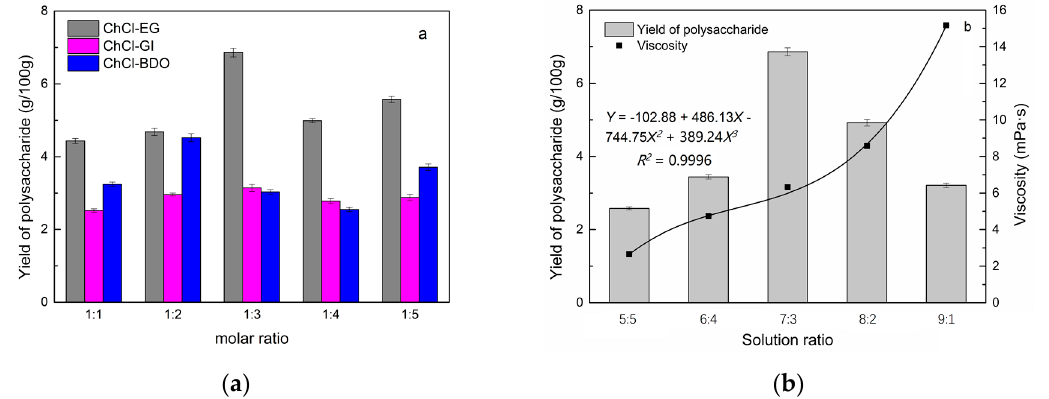
Figure 1. Screening of DES: ( a ) Effect of DES composition on the extraction yield of polysaccharide, ( b ) effect of water amount in the DES solution on the extraction yield of polysaccharide.